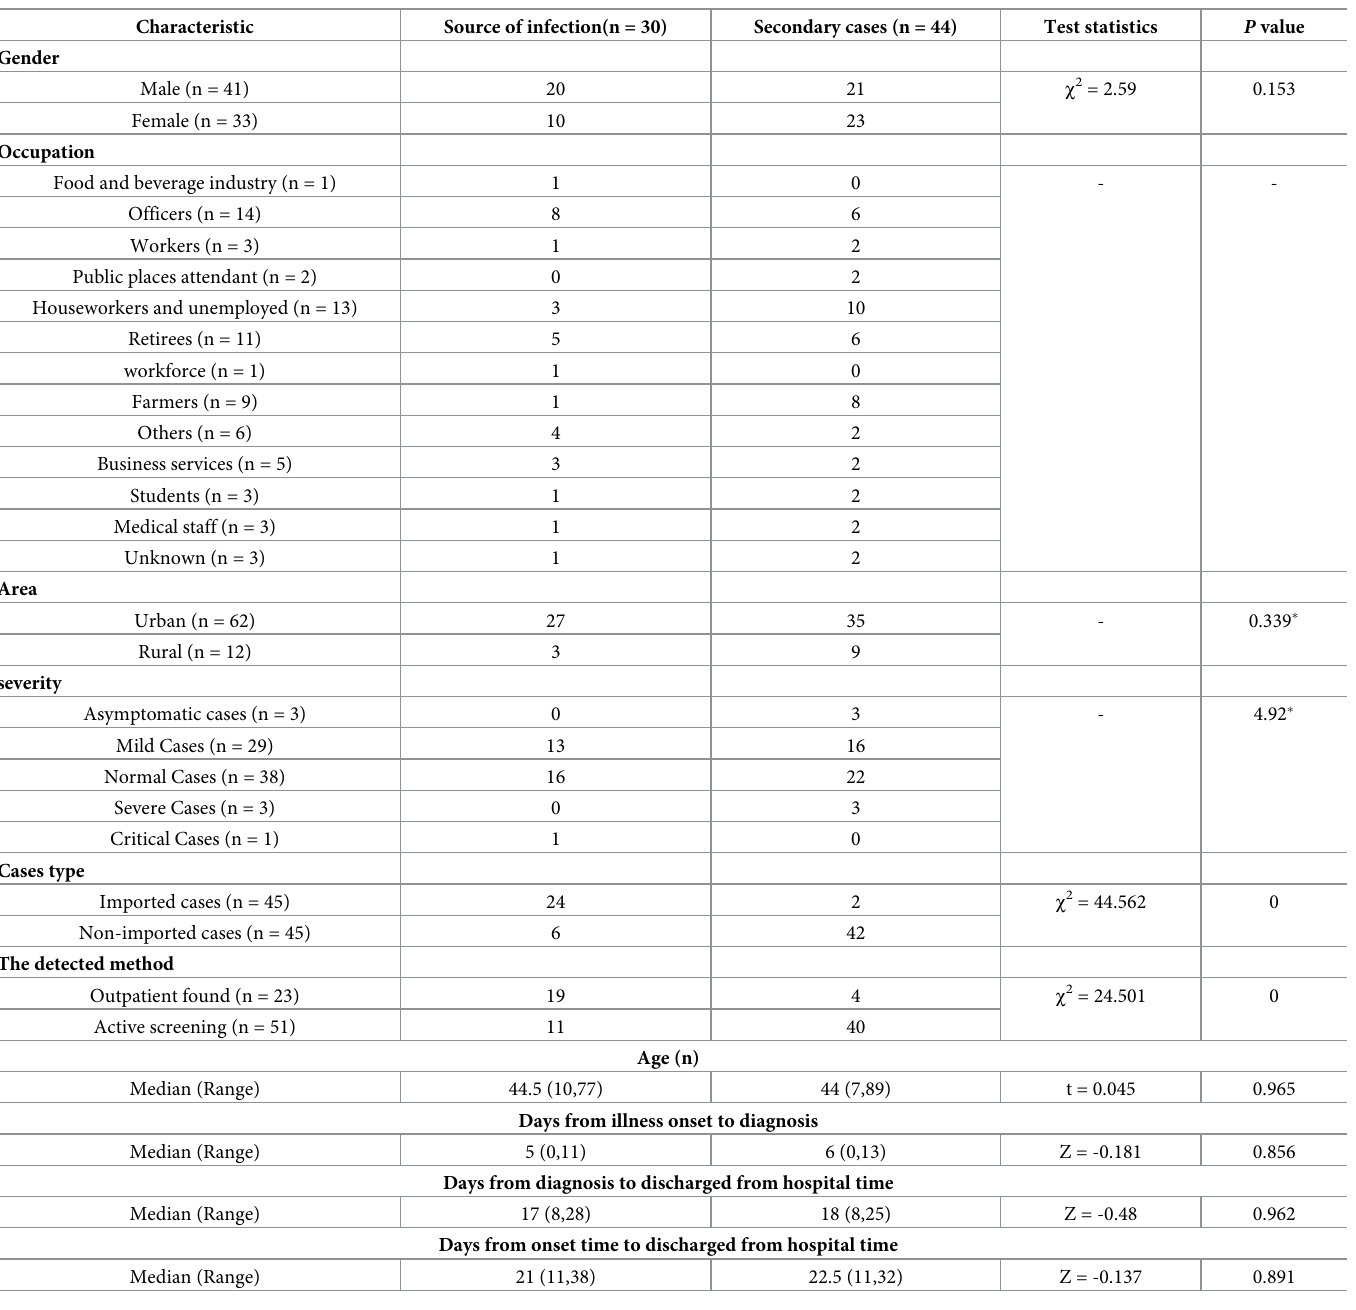
Table 4. Characteristics of cluster